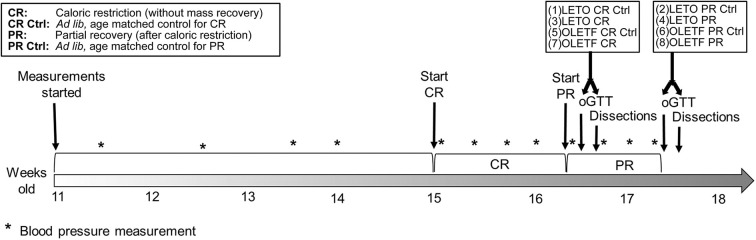
Study timeline. For both strains, first dissected groups were CR and CR control, and last dissected groups were PR and PR control.